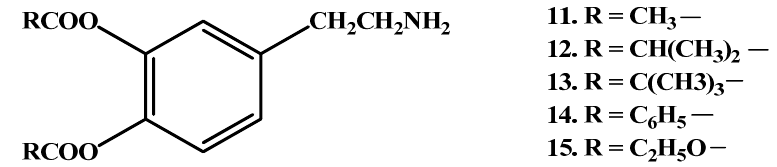
Figure 3. Chemical structures of lipophilic 3,4- O -diester prodrugs of DA, 11 – 15 .